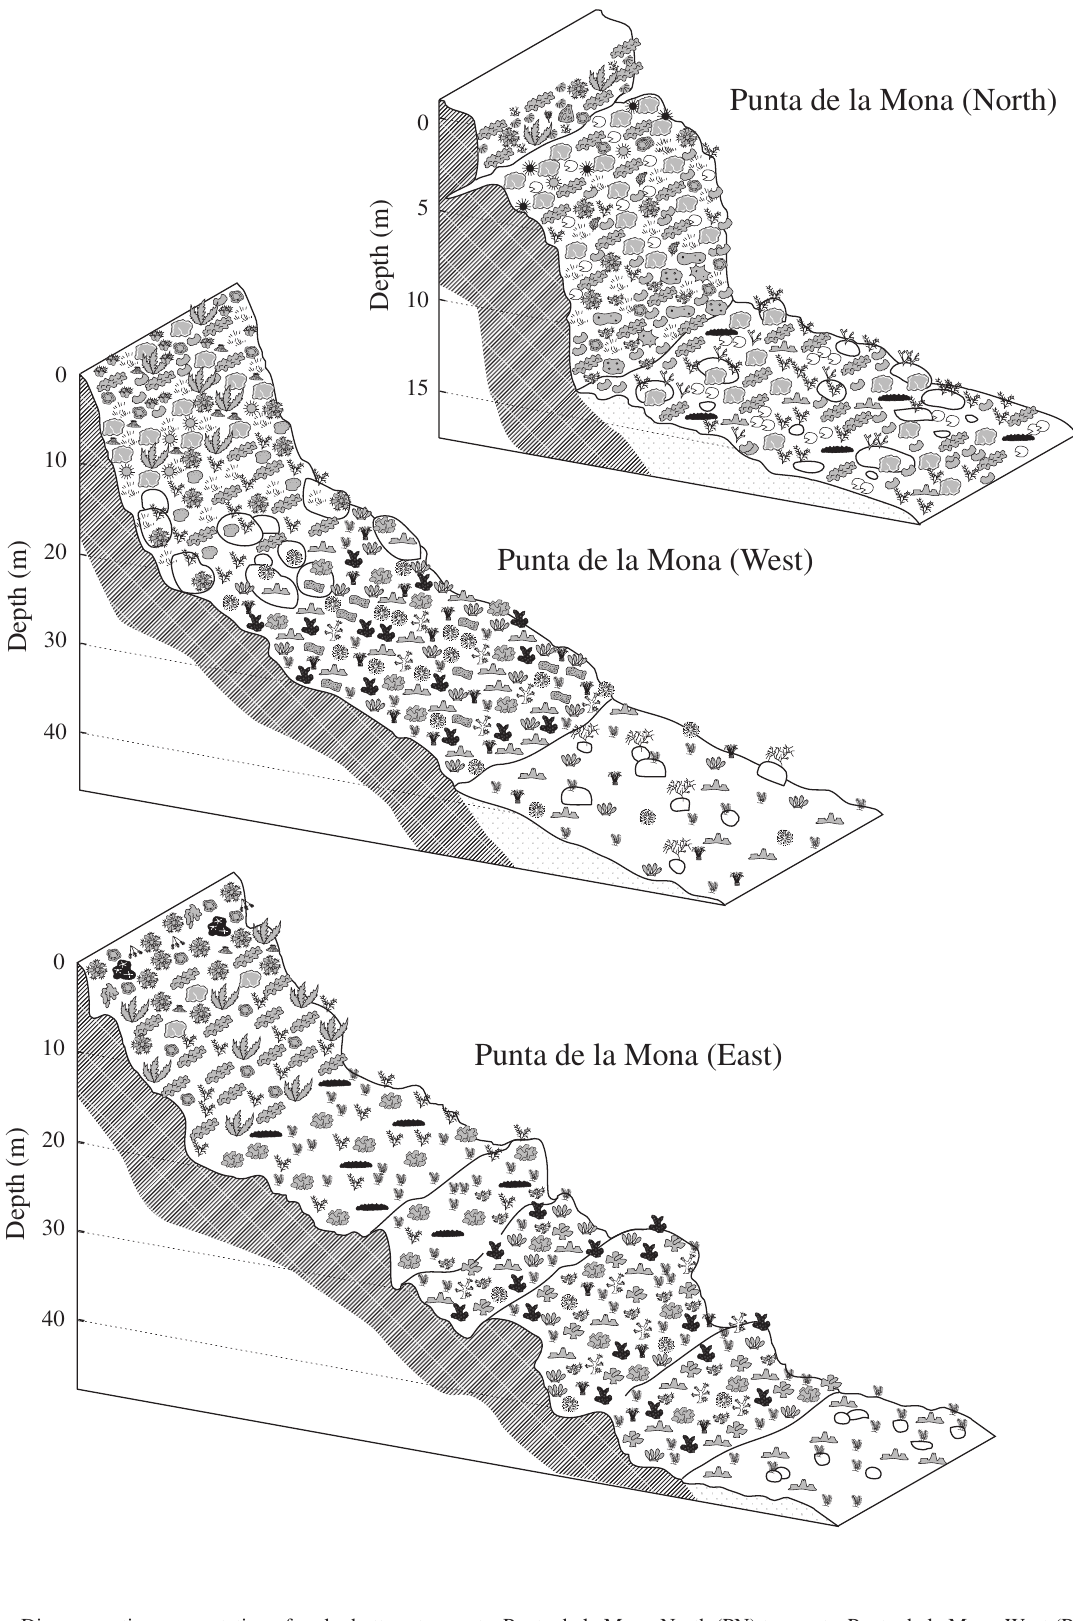
F IG . 3. – Diagrammatic representation of rocky bottom transects: Punta de la Mona-North (PN) transects, Punta de la Mona-West (PW) and Punta de la Mona-East (PE)